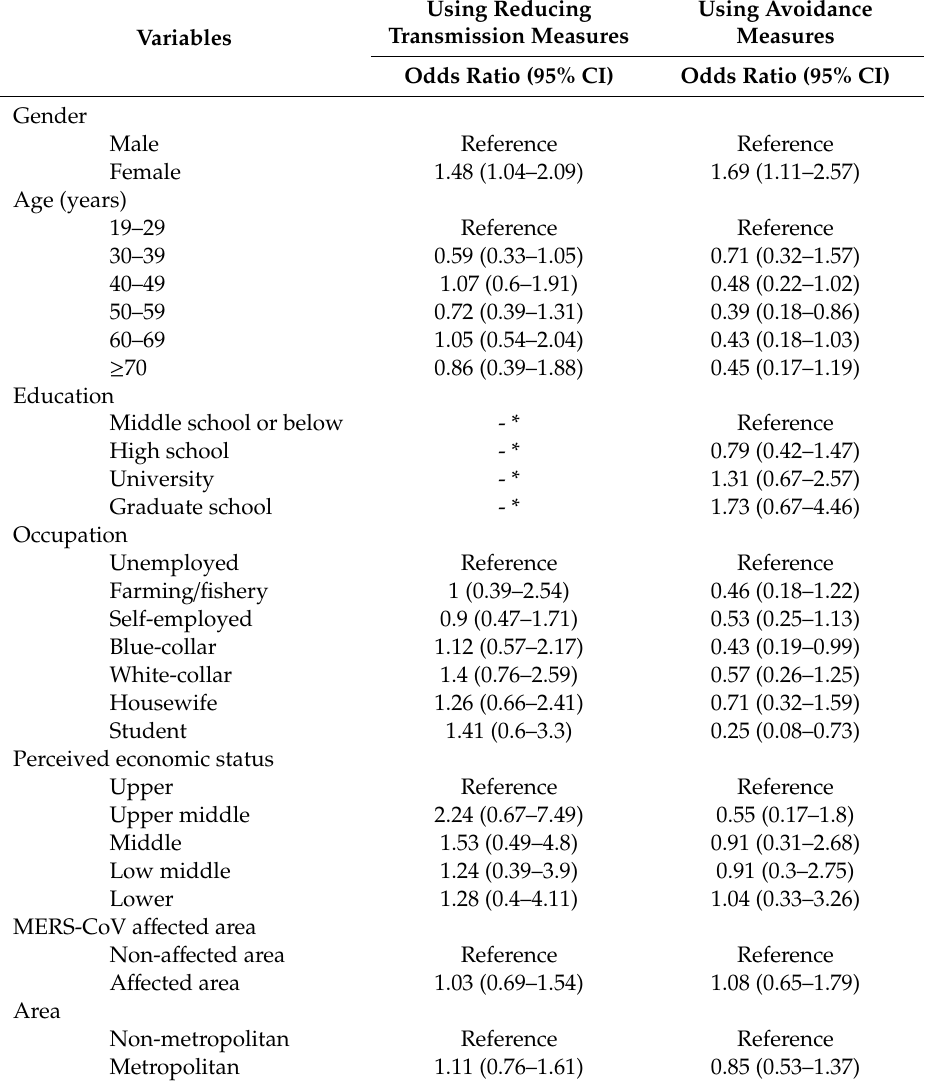
Table 3. Association between personal characteristics and nonpharmaceutical preventive behaviors against